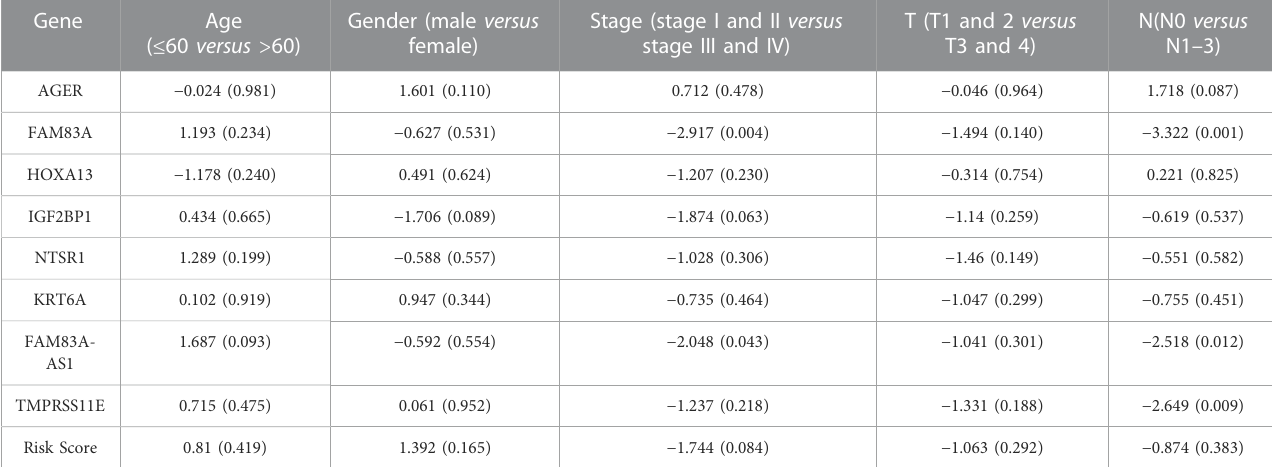
TABLE 3 Clinical correlation analysis of EMT-LUAD related genes with independent signi fi cant prognostic value.